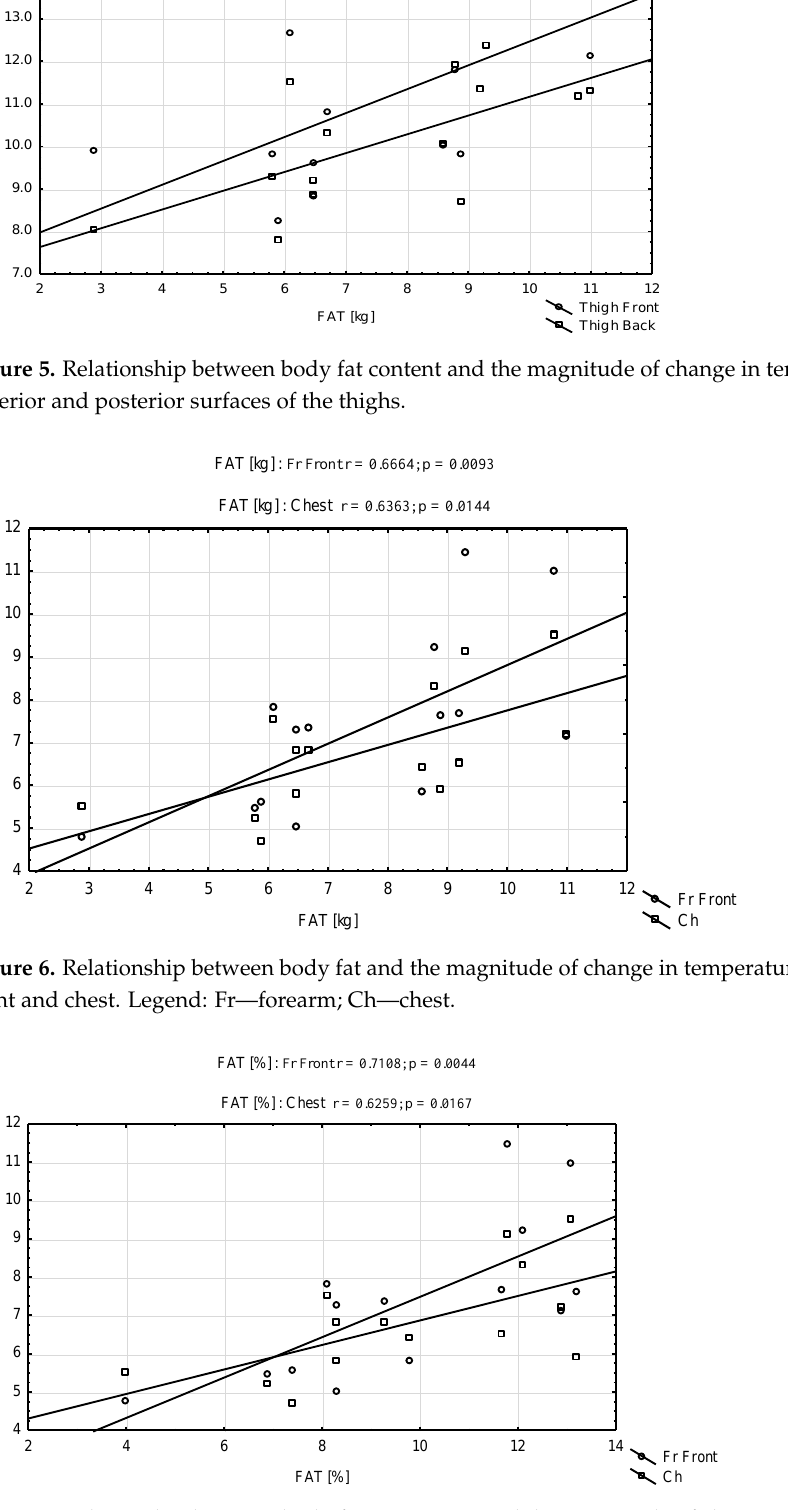
Figure 7. Relationship between body fat percentage and the magnitude of change in temperature of the forearm front and chest. Legend: Fr — forearm; Ch — chest.